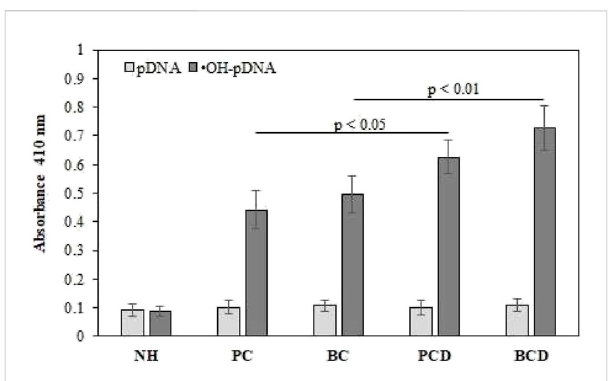
FIGURE 4 DirectbindingELISAofserumantibodiesagainstnativeand pDNA antigen. ELISA plates were coated with the respective antigen (5 μ g/mL). All the samples were tested in triplicates. Signi fi cance was represent as p < 0.05 and p <